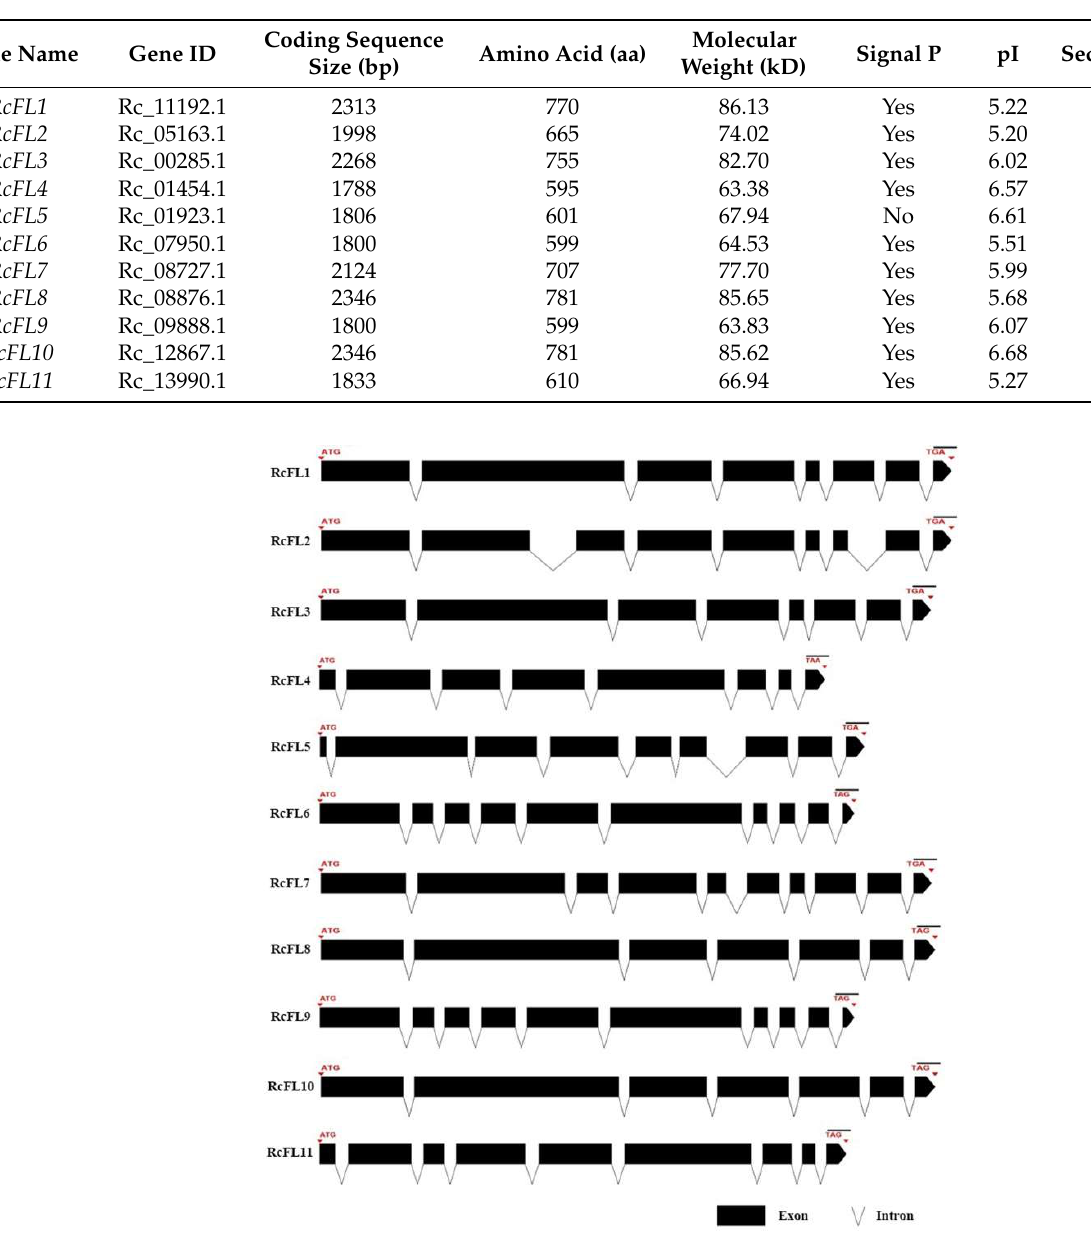
Figure 1. Structures of MEP36 -contained metalloprotease genes of R. cerealis . Exons and introns are indicated by black boxes and lines.